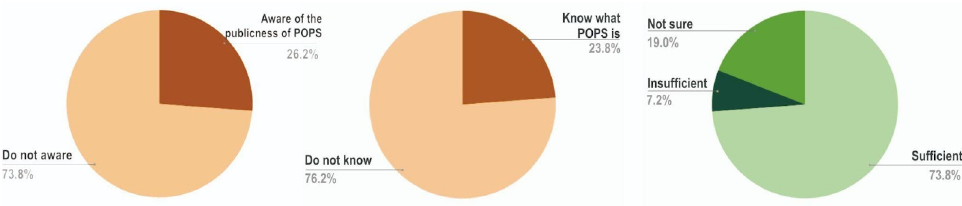
Figure 7. Key results of the survey. Yellow chart: respondent’s awareness of POPS, green chart: respondents’ opinion on open space in YBD.